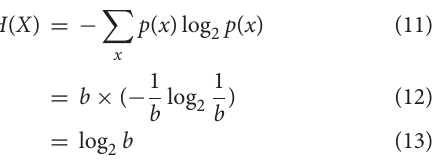
Frontiers in Physics |